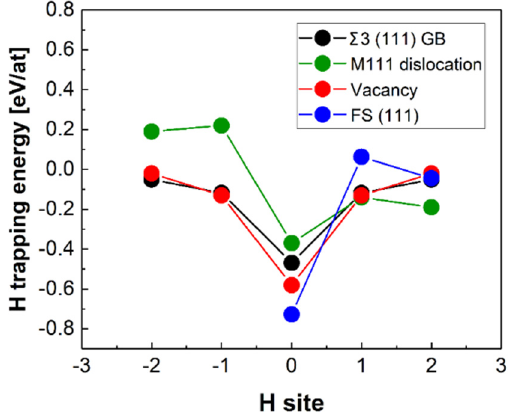
Table 4. H-trapping energies in Fe (in eV/at). Literature data [12–18,23,27] and the results of this work. Zero point energy correction added to the 0 K results has been taken from references [17,27,62], and it is shown in the parentheses. The trapping energies are presented relative to the geometrical centre of each defect indicated by 0. The considered trapping sites are located at the first, second and third atomic planes away from the corresponding defects, as indicated in Figures 2a and 3b. In the case of a vacancy, the next nearest neighbour TS positions are shown. Minus signs refer either to mirrored or to compressed (in the case of M111 dislocation) crystallographic directions.